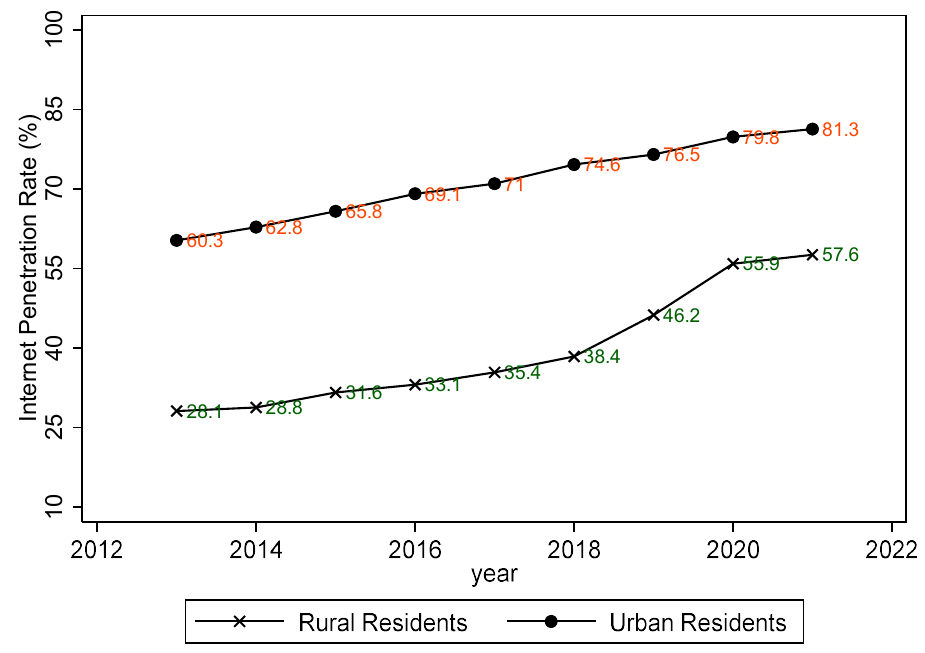
Figure A1. The increasing trend of internet users age 60 and above in China. Source: China Internet Network Information Center (CINIC).